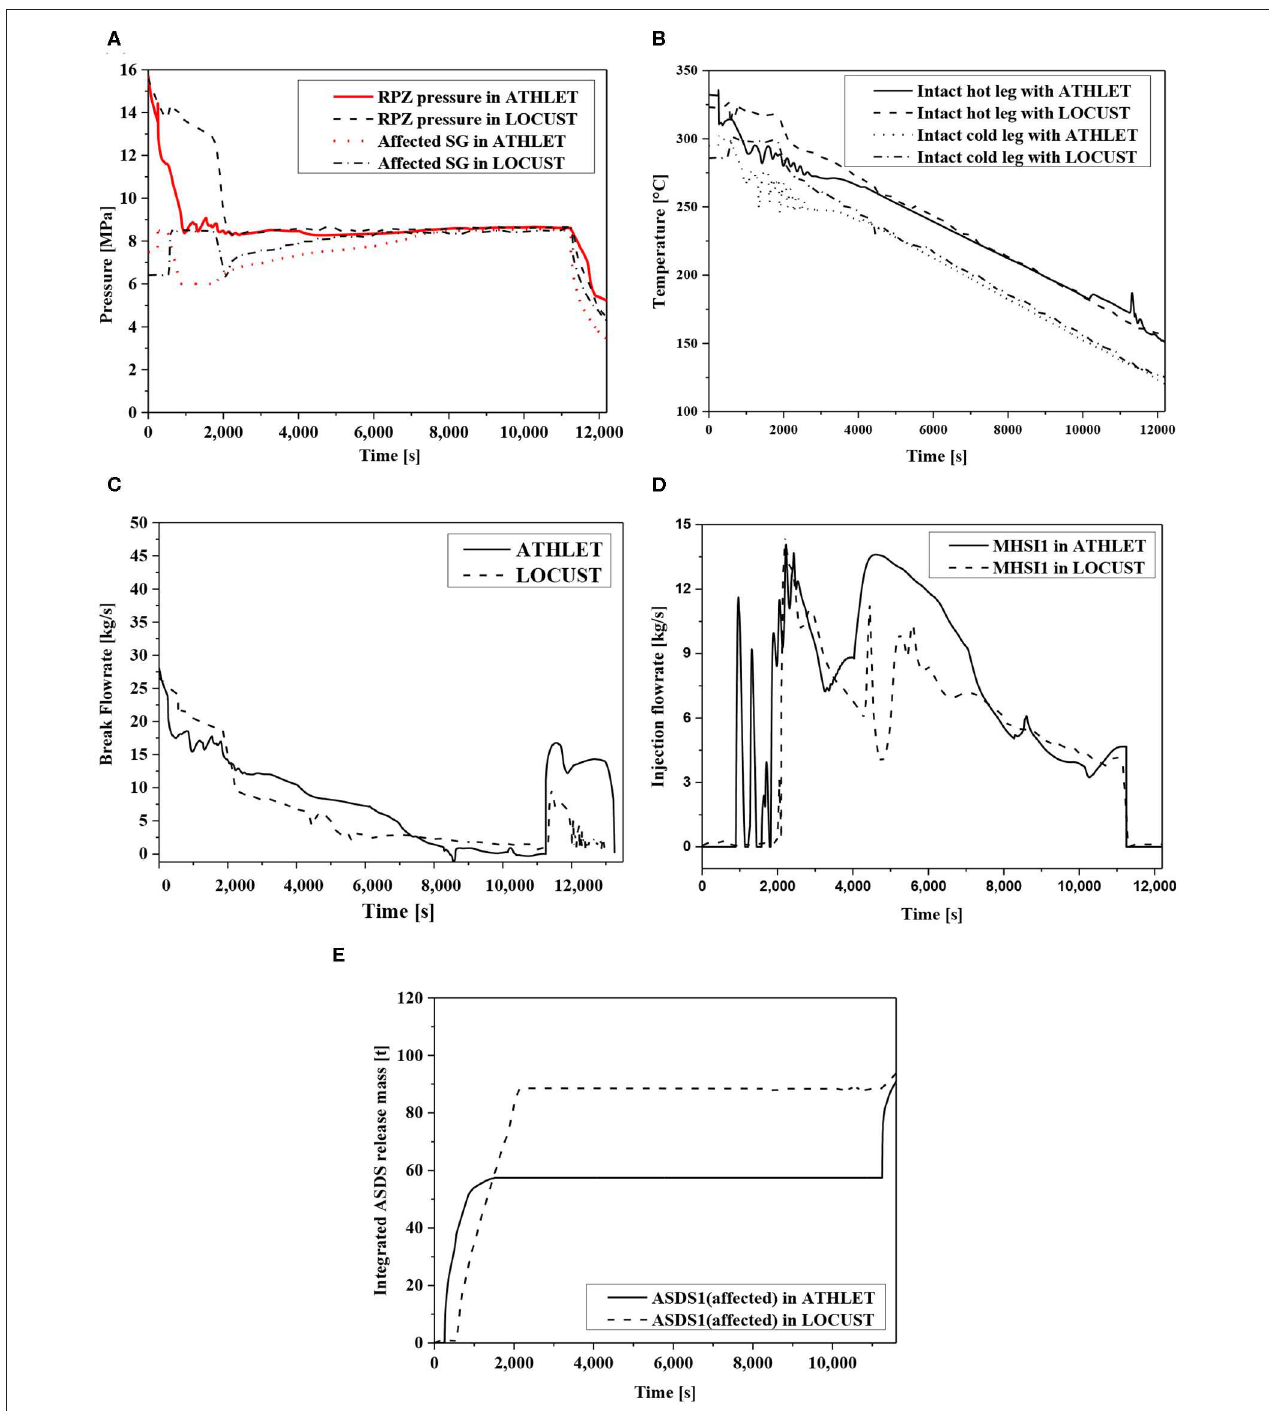
FIGURE 8 | Simulation results of SGTR for HPR1000. (A) The pressure change of primary and secondary side. (B) The change of cold leg and hot leg temperature. (C) The SGTR break flowrate. (D) The MHSI injection rate. (E) The integrated mass released via ASDS.